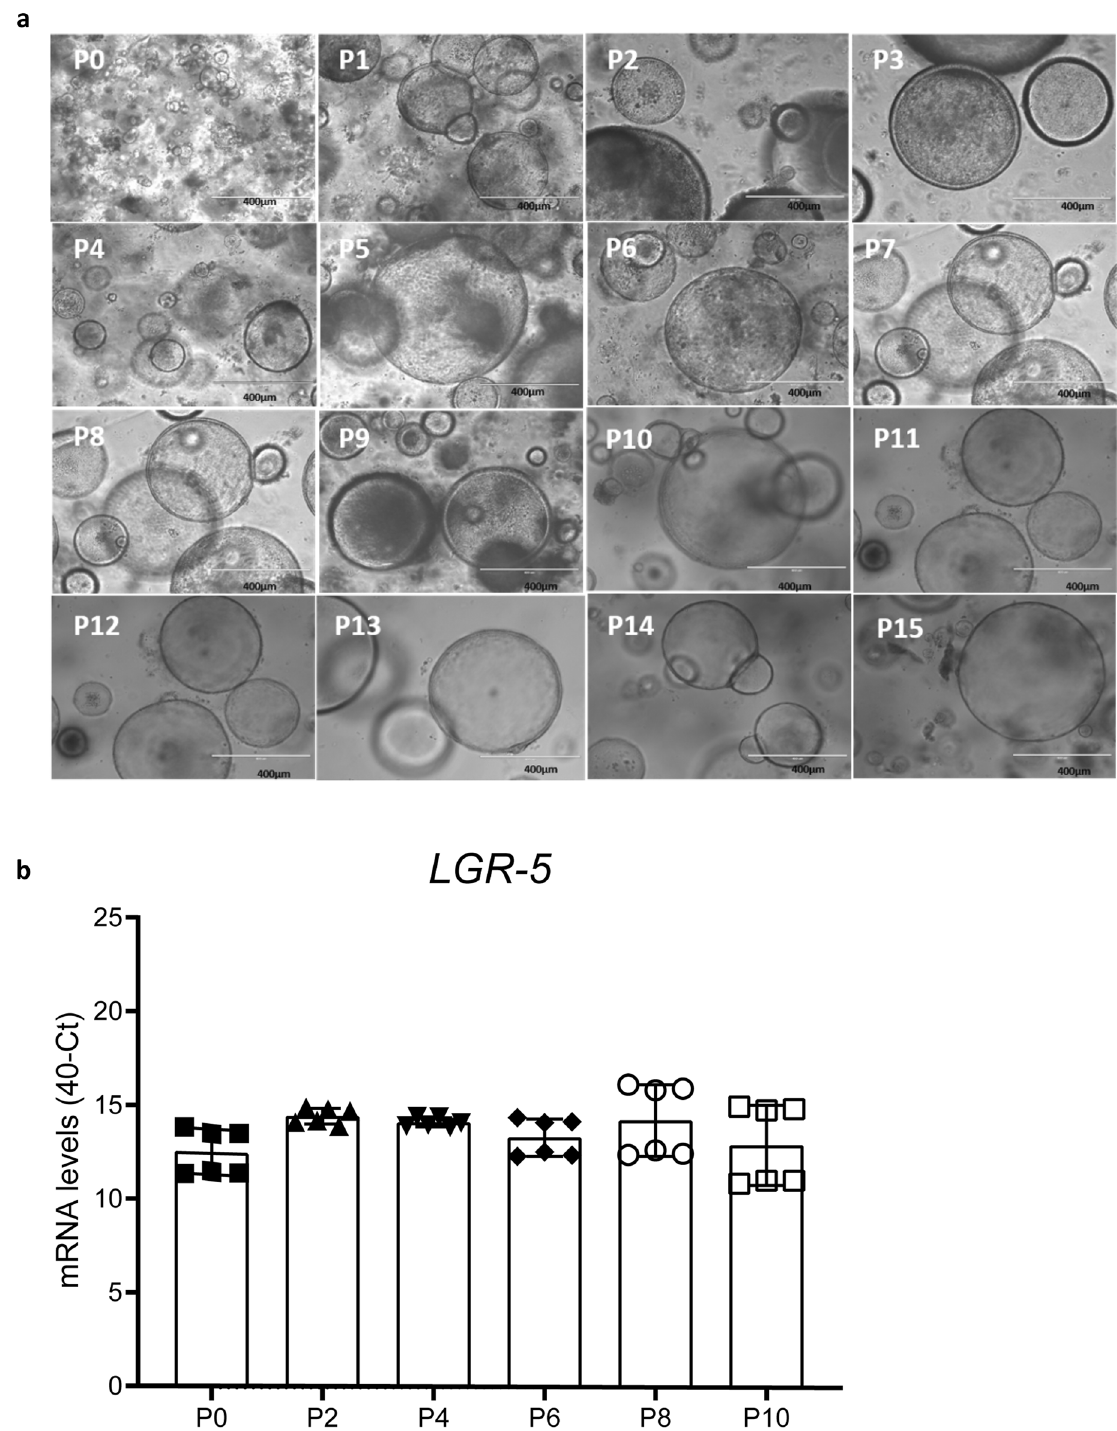
Figure 5. Longevity of the chicken intestinal organoids. (a) Brightfield images of chicken intestinal organoids cultured in chicken organoid culture medium. All pictures were taken 2 days after passaging. Scale bar: 400 µm. ( b) mRNA levels of LGR5 in 3D embryonic chicken intestinal organoids, expressed as 40-Ct values with GAPDH as a reference gene. Two independent isolations were performed in technical triplicates. The error bars represent the standard deviation of the